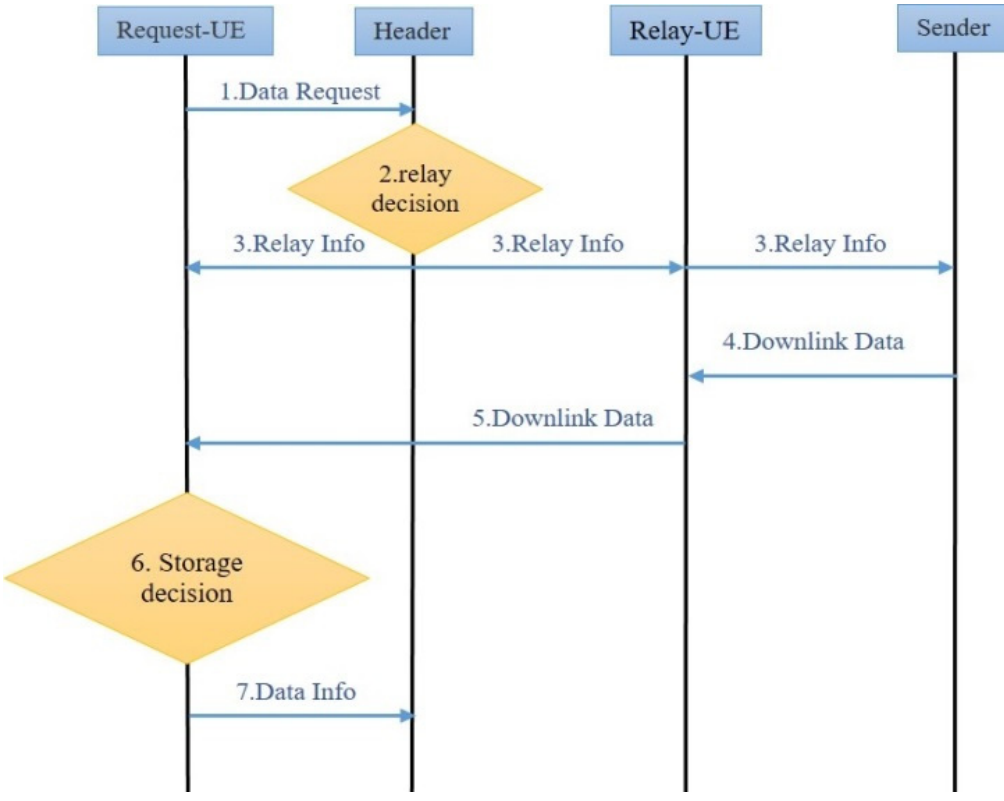
Figure 5. Signaling diagram for downloading content from another group member.